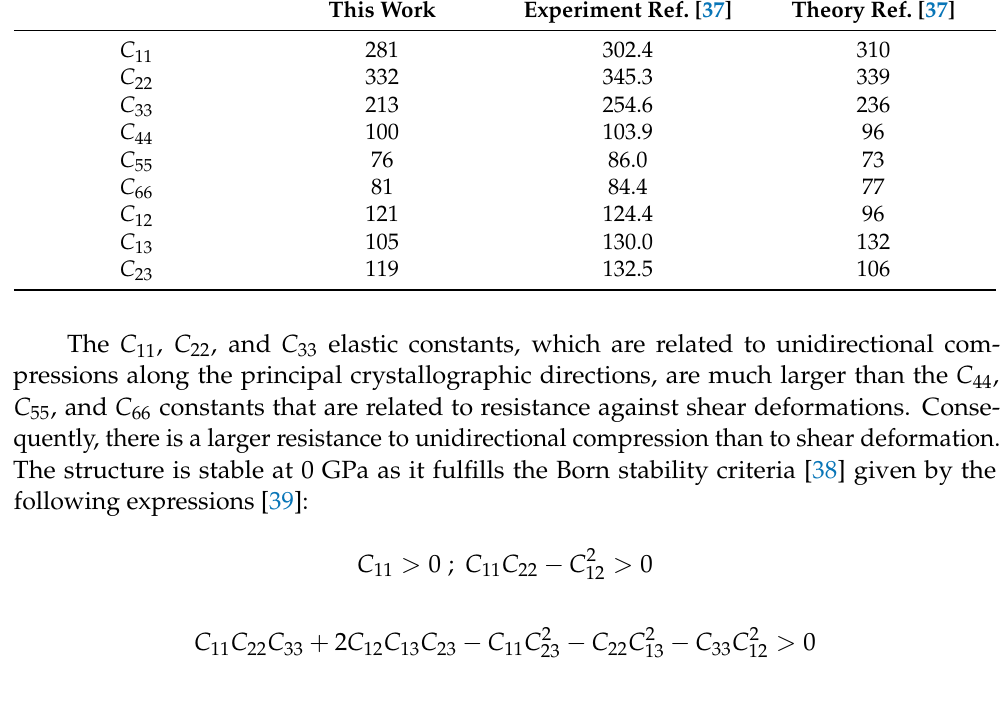
Table 4. Elastic constants (in GPa) of DyScO 3 perovskite at 0 GPa. (The Pbnm setting is used.) This Work Experiment Ref. [37] Theory Ref. [37] C 11 281 302.4 310 C 22 332 345.3